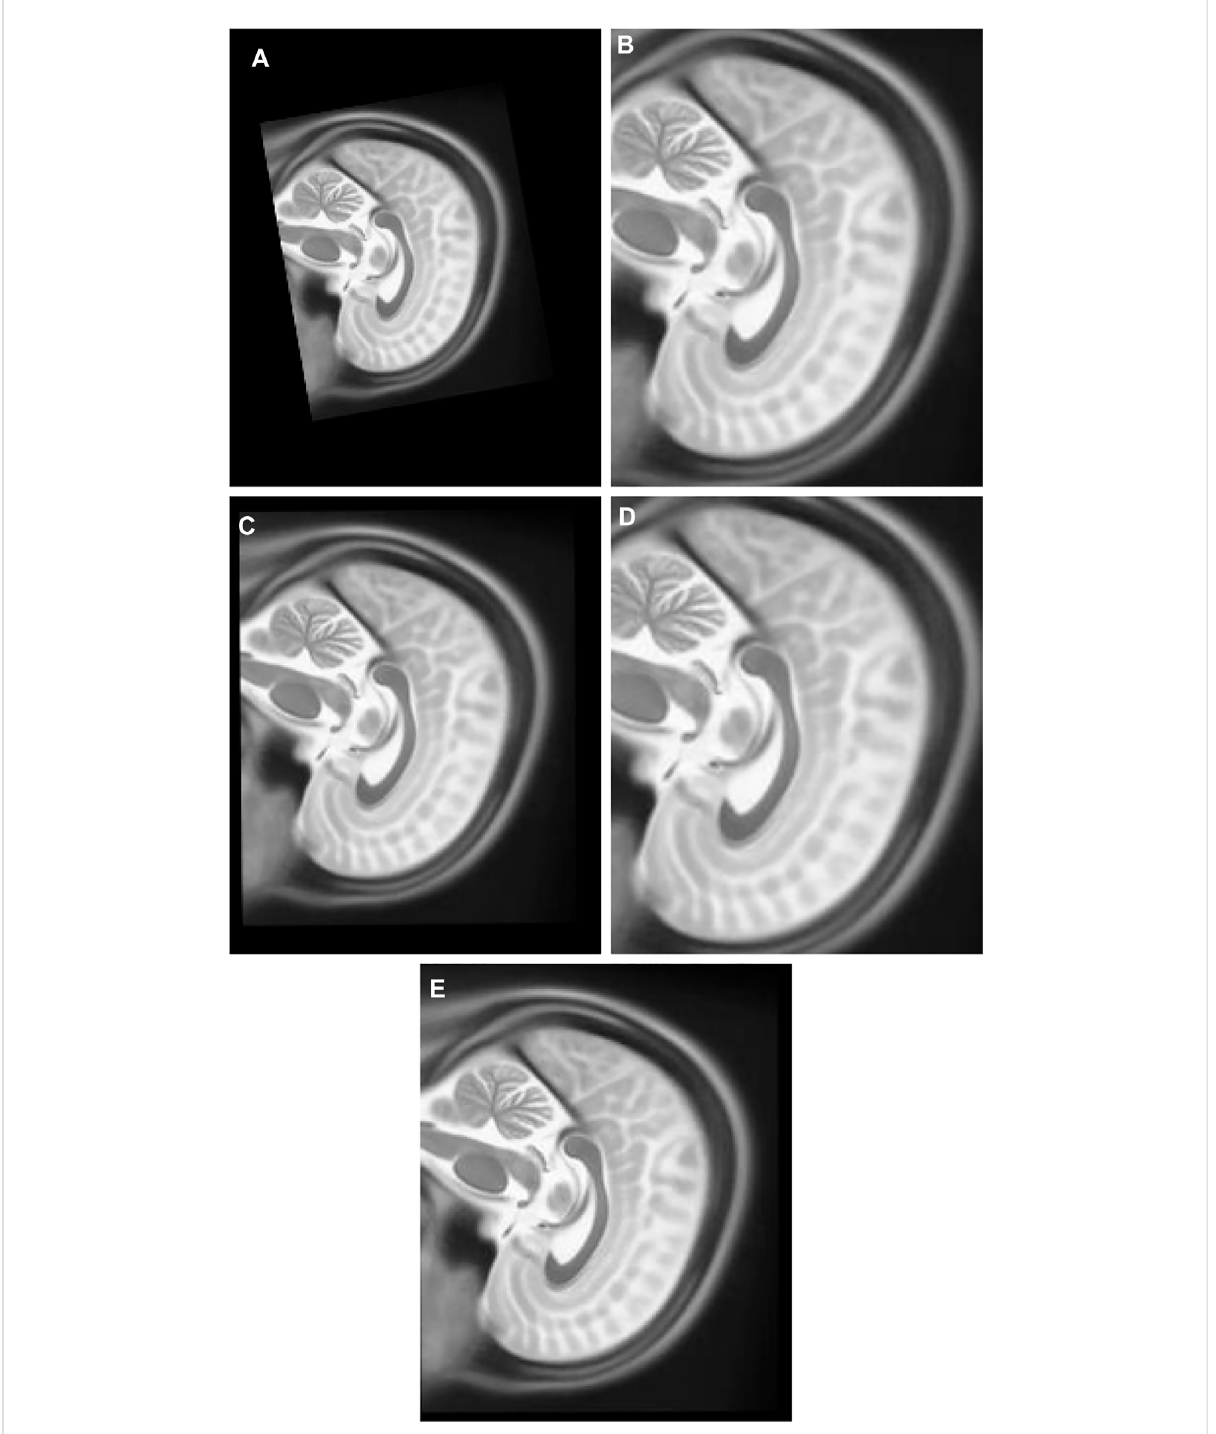
FIGURE 11 (A) Multi Modal Experiment 3 Float: row fi rst left. (B) Multi Modal Experiment 3 GA output: row fi rst right. (C) Multi Modal Experiment 3 PSO output: row second left. (D) Multi Modal Experiment 4 PSO and Powell Output: row second right. (E) Multi Modal Experiment 5 TPSysIR Output: row third